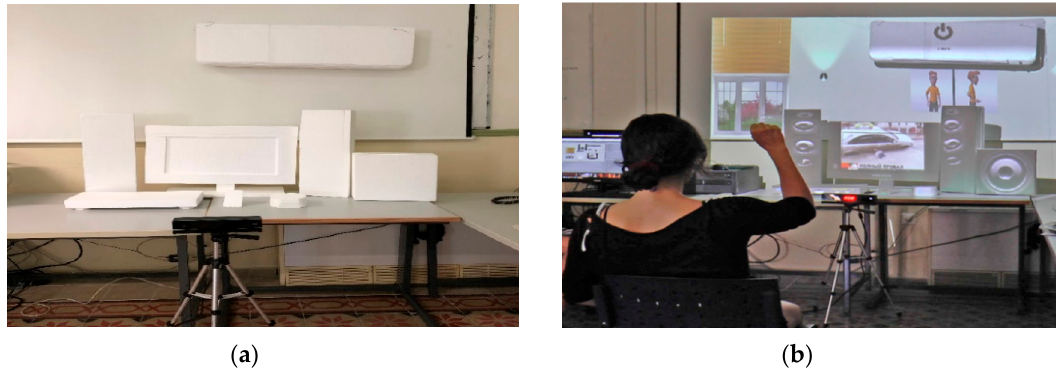
Figure 2. ( a ) Dummy devices created by foil; ( b ) Projection of 2D content on the wall (for blinds, lights and help-videos), and on the dummy devices with projection mapping.